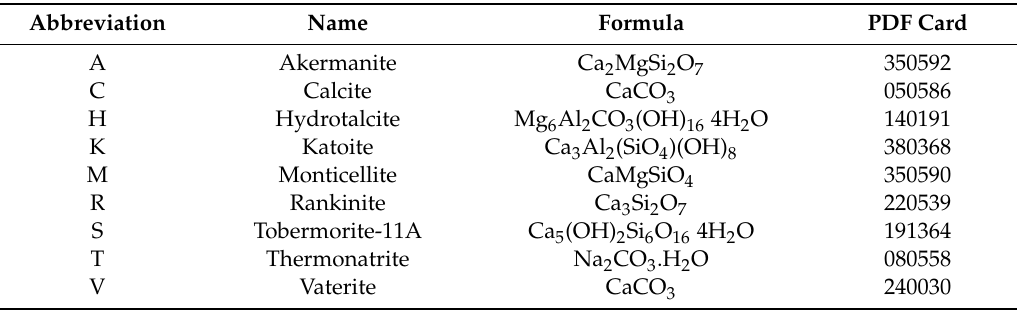
Table 5. Assignment of the XRD peaks in